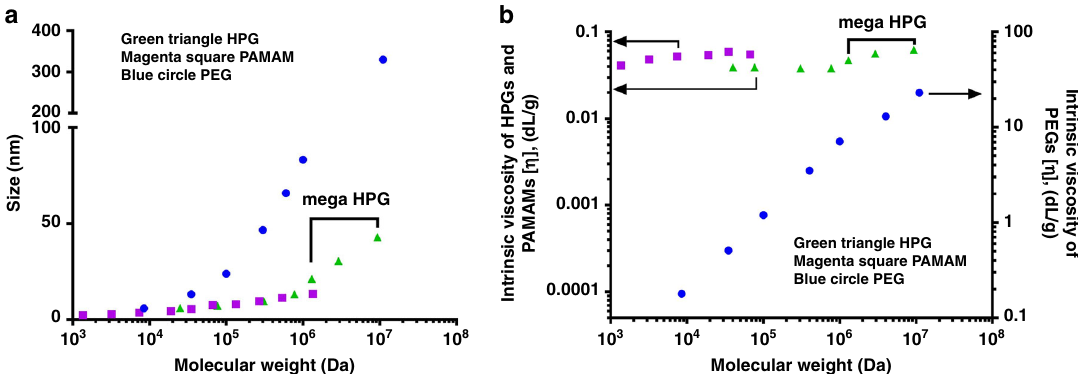
Fig. 2 Comparison of solution properties of mega HPGs with PEG and PAMAM dendrimers. a Variation of hydrodynamic size of the polymer with molecular weight. Mega HPGs and their low molecular weight counterparts ( fi rst four data points), and PAMAM dendrimers are compact in size compared to PEG polymers. The values for high molecular weight HPGs (76.5, 307, and 771 kDa) are obtained from literature 64 . For PEGs, the size of PEG-4 (11 MDa) was derived from R g and simulation studies 63 . b Dependence of intrinsic viscosity of the polymers with molecular weight (arrow shows the representative y -axis). Mega HPGs showed similar intrinsic viscosity behavior as that of PAMAM dendrimers; however, slight increment with molecular weight might was observed. The PEG systems showed liner dependency with molecular